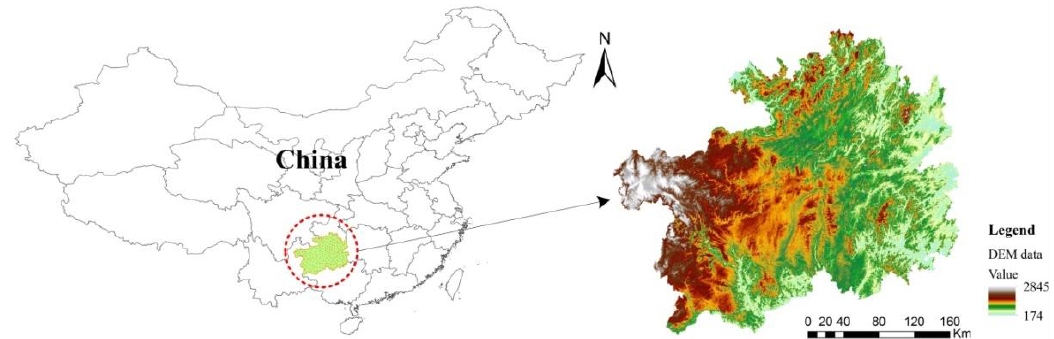
Figure 1. Study area of Guizhou province.